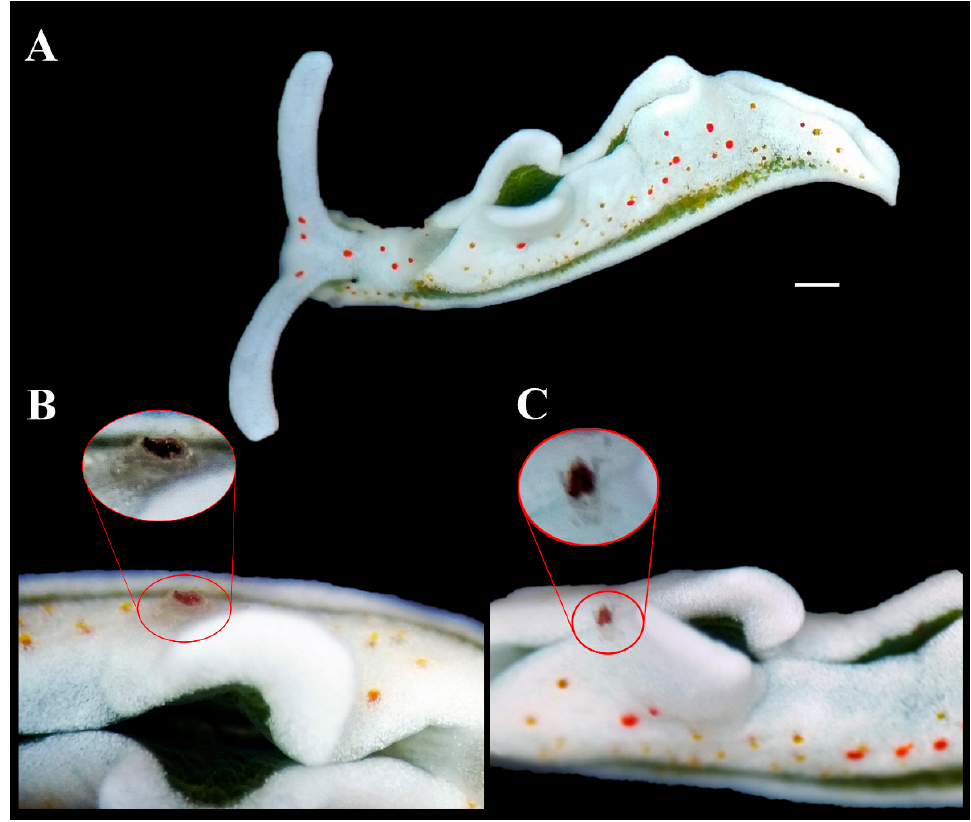
Figure 2. The new symbiotic relationship. ( A ) Elysia timida individual (Voucher RM3_1384) hosting the Pinnotheridae crustacean. ( B ) Frontal view of the pea crab. ( C ) Dorsal view of the pea crab (red circle) with the red dorsal spot visible on its carapace. Scale bar = 1 mm.